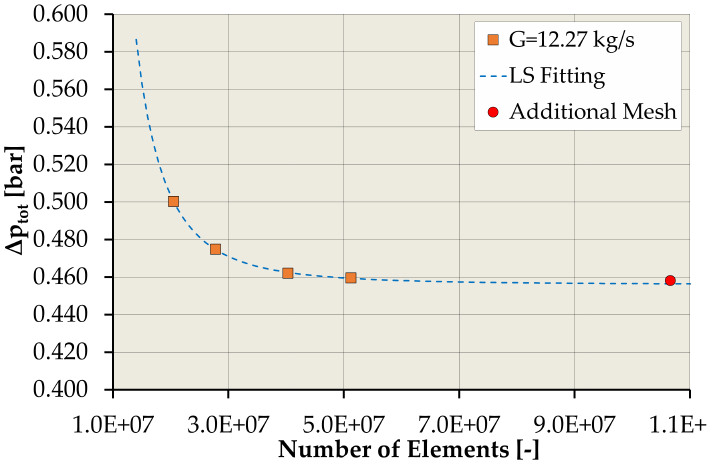
Figure 10. Grid independence results obtained for a mass flow rate of 12.27